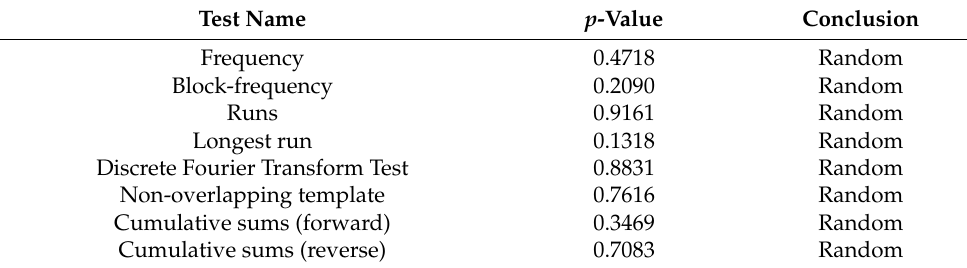
Table 10. NIST statistical